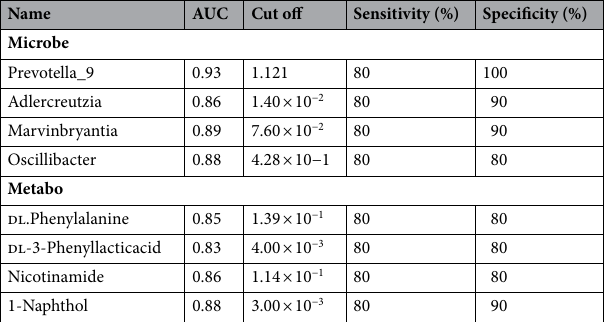
Table 1. ROC curve analysis between the control and IBS groups. Markers with an area under the ROC curve (AUC) above 0.8 (P < 0.05); both sensitivity and specificity above 80% were selected.